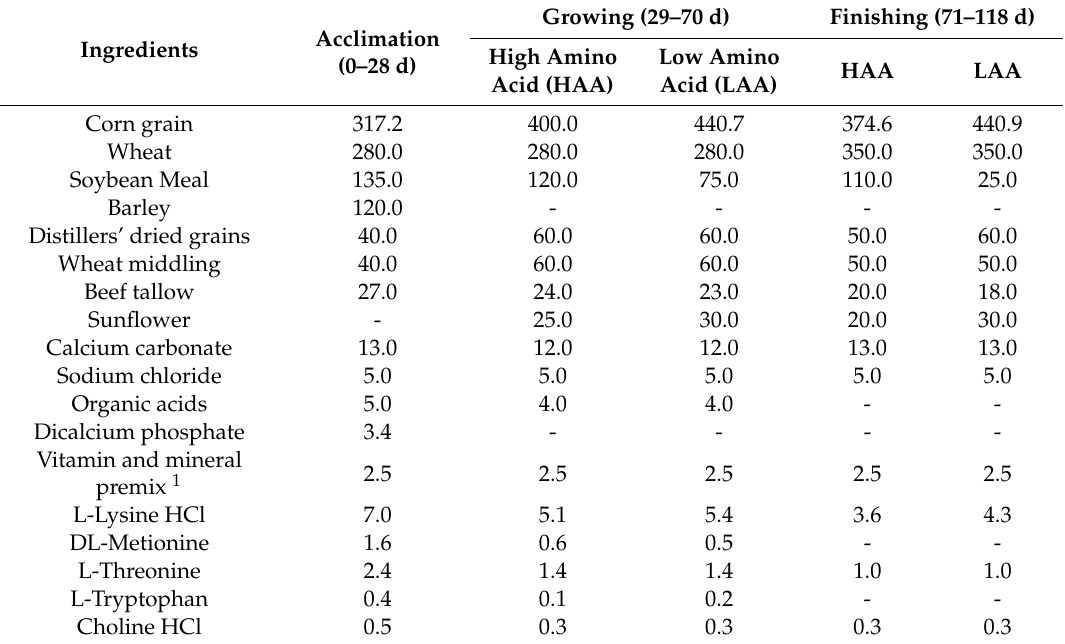
Table 1. Ingredient composition of the experimental feeds (g / kg as fed).